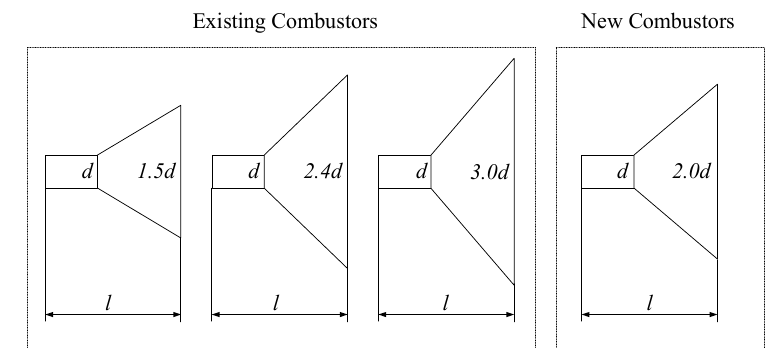
Figure 2. Structural representation of the existing combustors and the new combustor.